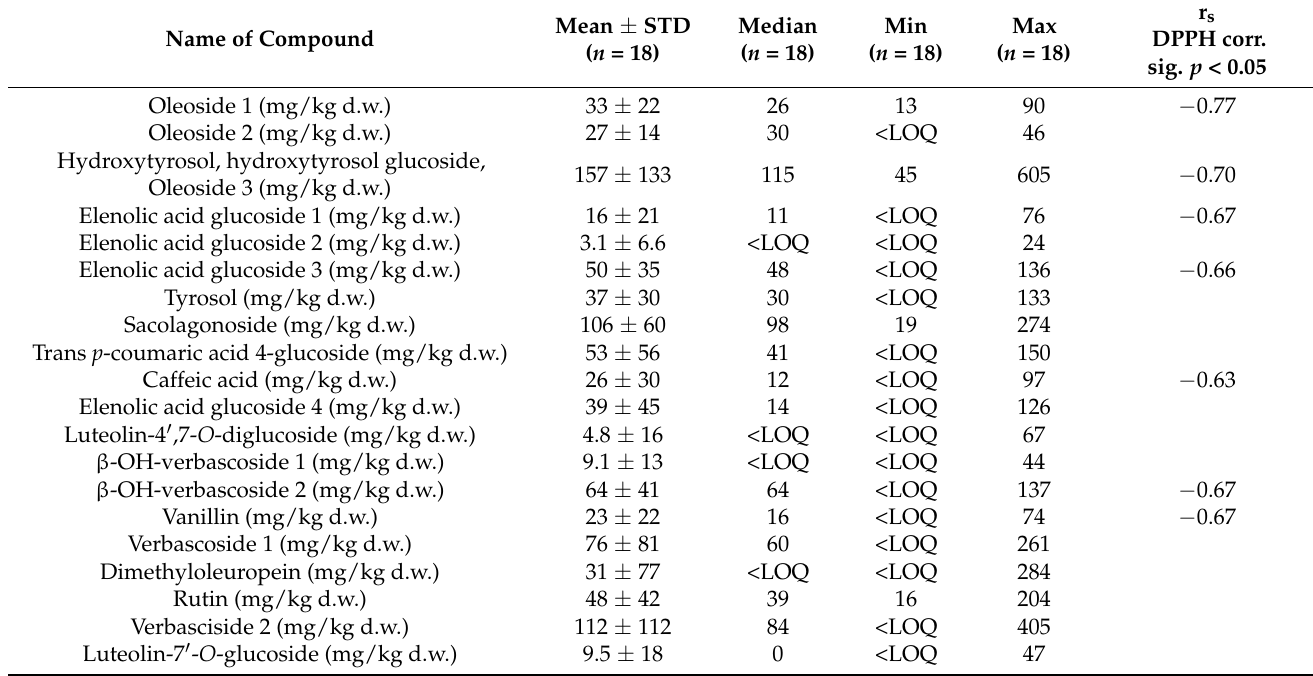
Table 1. Mean ± standard deviation (STD), median, minimum and maximum levels, total phenolic compounds, simple phenolic compounds, benzoic acids, cinnamic acids, flavonoids, secoiridoids in all pomace samples and Spearman Rank correlation coefficients between the determined levels of phenolic compounds and radical scavenging activity measured using 1,1-diphenyl-2-picrylhydrazyl (DPPH) assay. Mean ± STD Name of Compound Oleoside 1 (mg/kg d.w.) Oleoside 2 (mg/kg d.w.) Hydroxytyrosol, hydroxytyrosol glucoside, Oleoside 3 (mg/kg d.w.) Elenolic acid glucoside 1 (mg/kg d.w.) Elenolic acid glucoside 2 (mg/kg d.w.) Elenolic acid glucoside 3 (mg/kg d.w.) − 0.66 Tyrosol (mg/kg d.w.) Sacolagonoside (mg/kg d.w.) 106 ± 60 274 Trans p -coumaric acid 4-glucoside (mg/kg d.w.) Caffeic acid (mg/kg d.w.) − 0.63 Elenolic acid glucoside 4 (mg/kg d.w.) Luteolin-4 (cid:48) ,7- O -diglucoside (mg/kg d.w.) 4.8 ± 16 67 β -OH-verbascoside 1 (mg/kg d.w.) β -OH-verbascoside 2 (mg/kg d.w.) Vanillin (mg/kg d.w.) − 0.67 Verbascoside 1 (mg/kg d.w.) 76 ± 81 <LOQ 261 Dimethyloleuropein (mg/kg d.w.) 31 ± 77 <LOQ <LOQ 284 Rutin (mg/kg d.w.) 204 Verbasciside 2 (mg/kg d.w.) 112 ± 112 <LOQ 405 Luteolin-7 (cid:48) - O -glucoside (mg/kg